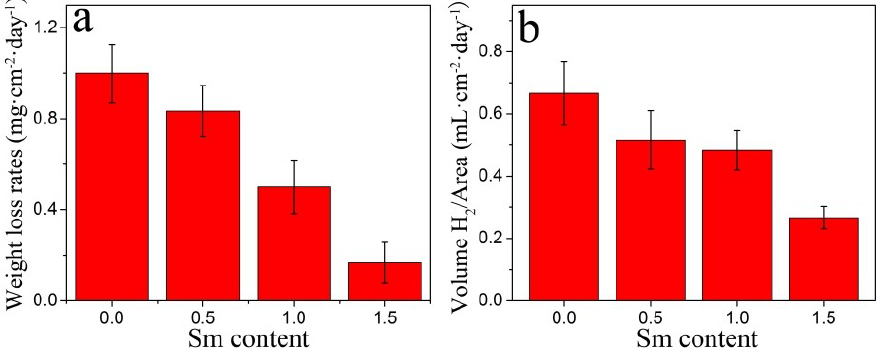
Figure 7. The corrosion rate of AZ91–xSm (x = 0, 0.5, 1.0, 1.5 wt %) magnesium alloys treated with ultrasound, as measured by ( a ) weight loss ( b ) hydrogen evolution reaction.